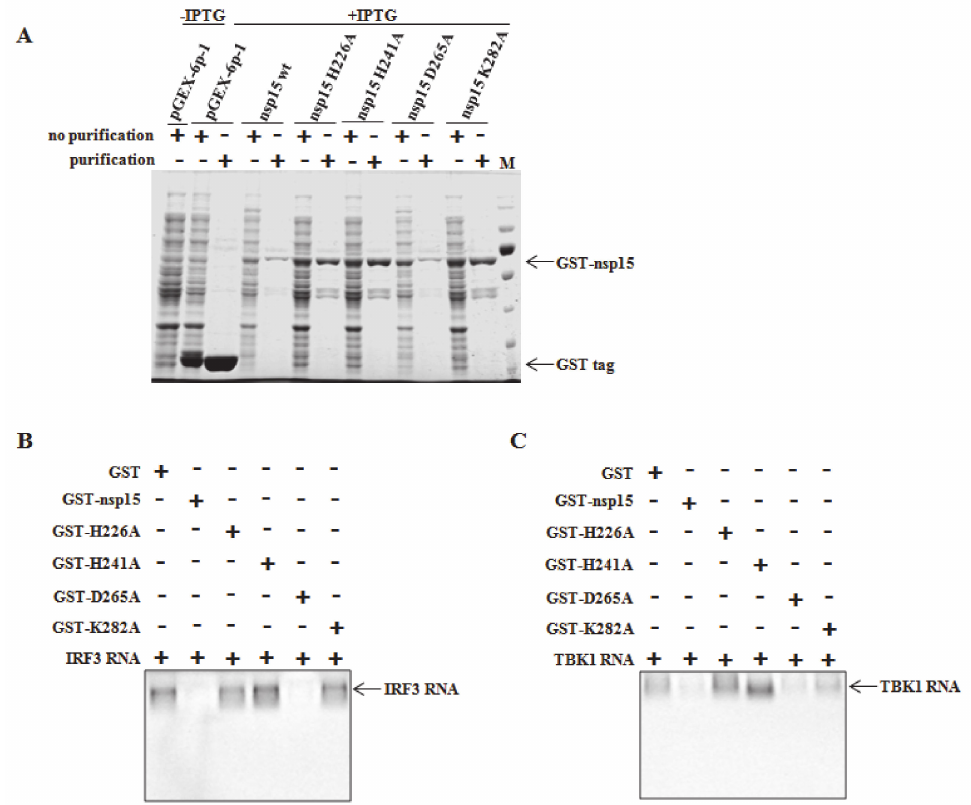
Figure 5. Degradation of TBK1 and IFR3 RNA by PEDV nsp15. ( A ) Wild-type PEDV nsp15 as well as its mutants (H226A, H241A, D265A and K282A) were cloned into prokaryotic expression vector of pGEX-6p-1, respectively. Targeted recombinant protein were expressed post induction with IPTG at the